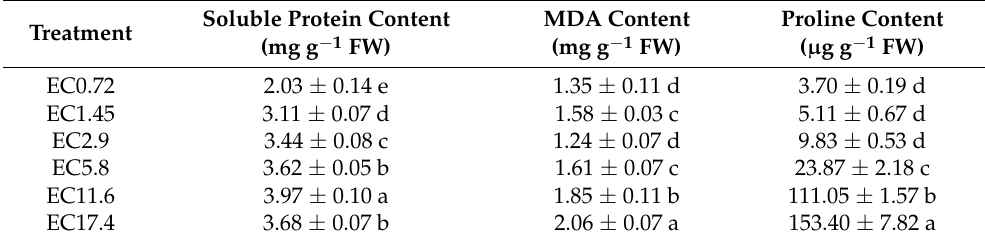
Table 2. Effects of different EC on soluble protein, malondialdehyde (MDA), and proline contents of sweet pepper after 25 days of